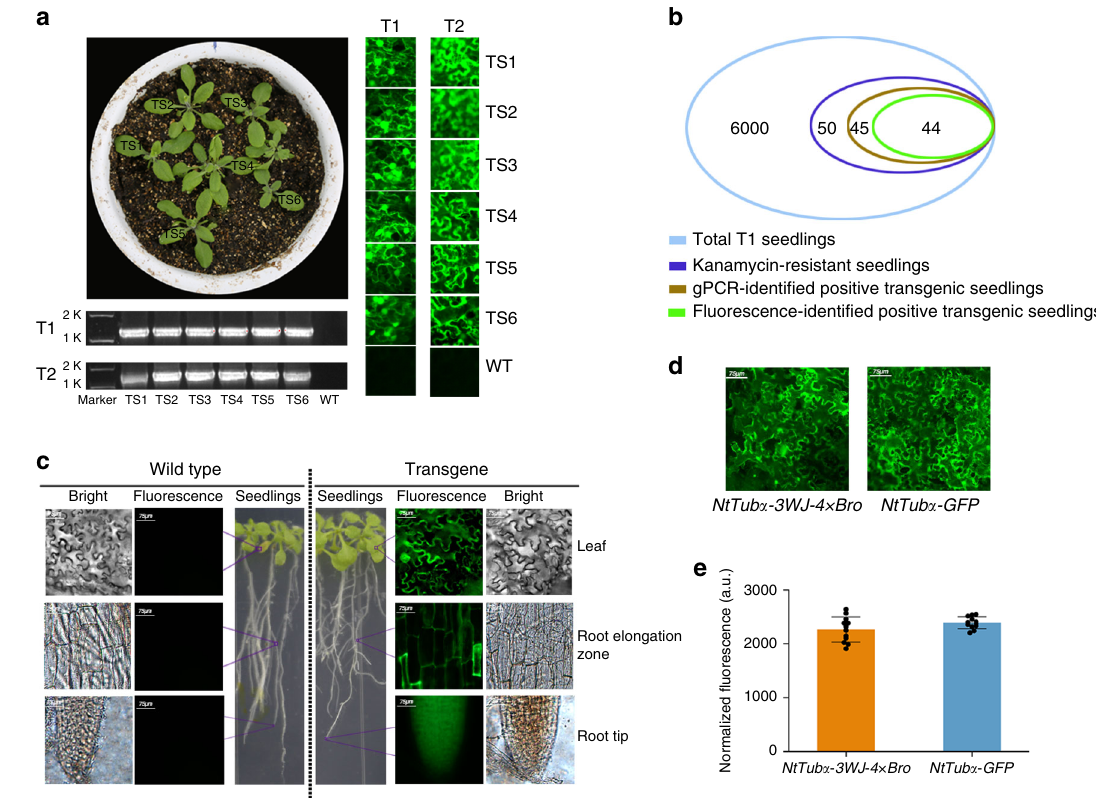
Fig. 7 Identi fi cation of transgenic A. thaliana and expression analysis of target genes using the 3WJ-4×Bro/DFBH-1T reporter system. a , b Identi fi cation of T 1 and T 2 transgenic A. thaliana . a Representative image of transgene identi fi cation by 3WJ-4× Bro fl uorescence (right) and RT-PCR (bottom). TS transgenic lines, WT wild type, T 1 , T 2 transgenic generations 1 and 2. b Numerical comparison of positive transgenic plants identi fi ed by the two methods above. c Expression of NtTub α - 3WJ-4 × Bro in different tissues of transgenic A. thaliana . The wild type was used as control. d The imaging comparison of the 3WJ-4 × Bro/DFBH-1T system (left) and the GFP reporter system (right). Scale bars, 75 μ m. e Quantitative comparison of fl uorescence intensity between the 3WJ-4 × Bro/DFBH-1T and GFP reporter systems. Error bars depict the mean ± s.d. ( n = 12). All experiments were repeated three independent times with the same conclusion. Source Data underlying a – c, e are provided as a Source Data fi le.